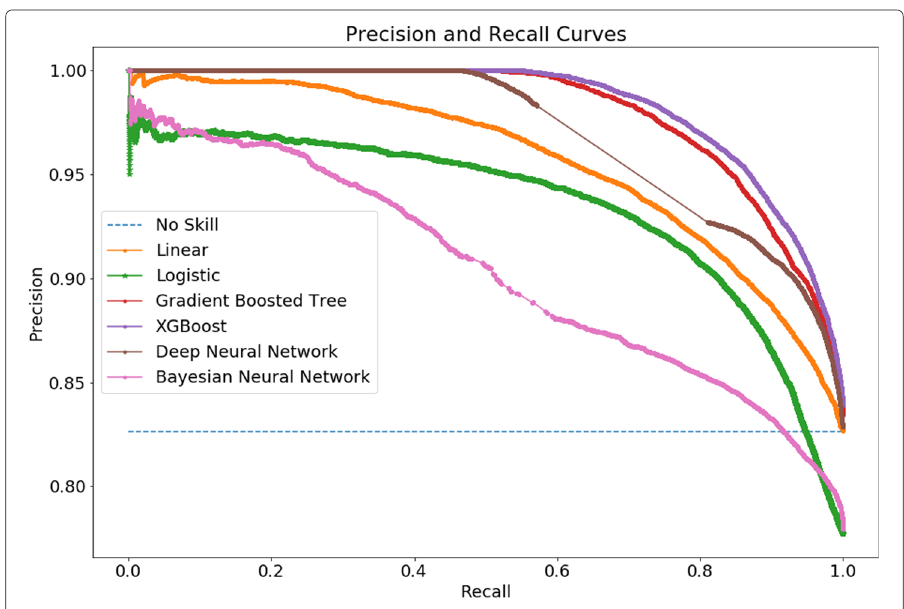
Fig. 4 Precision and recall curves